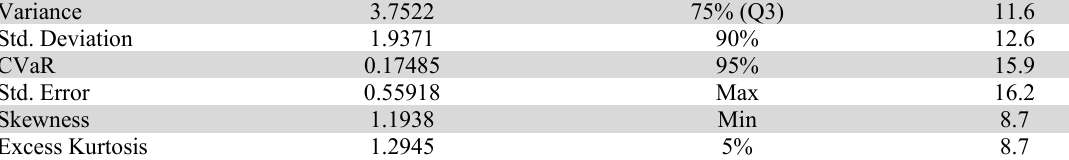
Results of statistical analysis of yield data